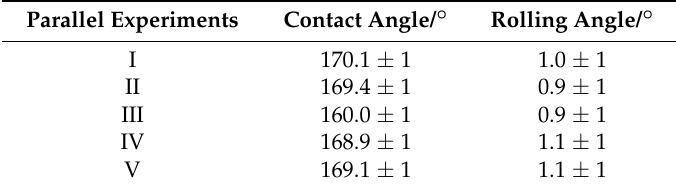
Table 1. The results of the contact and the rolling angles of the SAFFs in five parallel experiments, under the same condition.